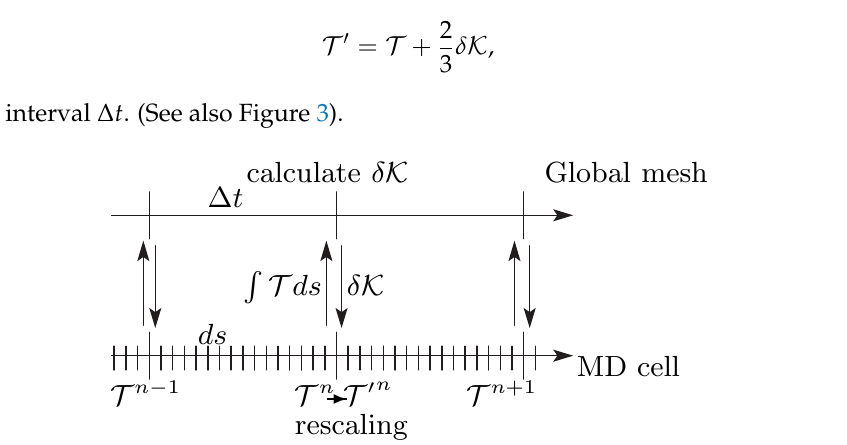
Figure 3. The time schedule scheme for the calculation of the temperature in the SMD method. The upper side represents the progress on the global mesh system, and the lower side represents the progress in the sub-MD cell. The time interval of the synchronization ∆ t = 1 and the time-step size of the MD simulation ds = 0.0025 are